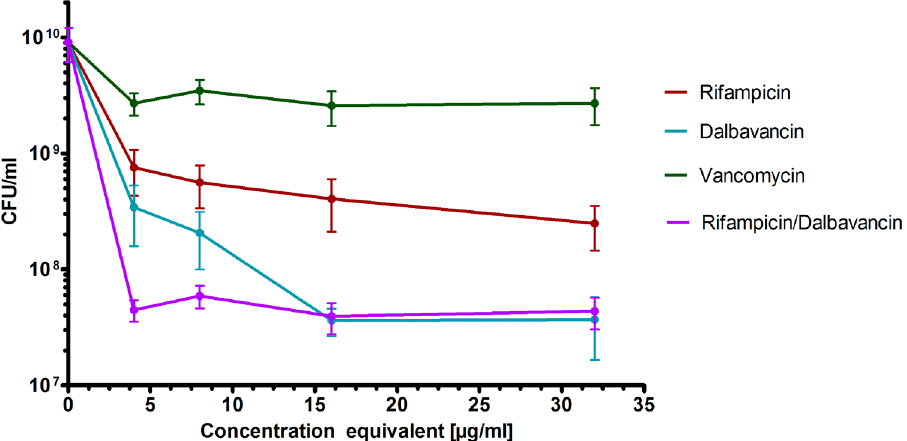
Figure 1. Reduction of CFU/ml of S. aureus biofilms grown on polyethylene discs by different antimicrobials. The x-axis represents the concentration equivalents (for details see “Methods” section). Values given as mean ± standard deviation